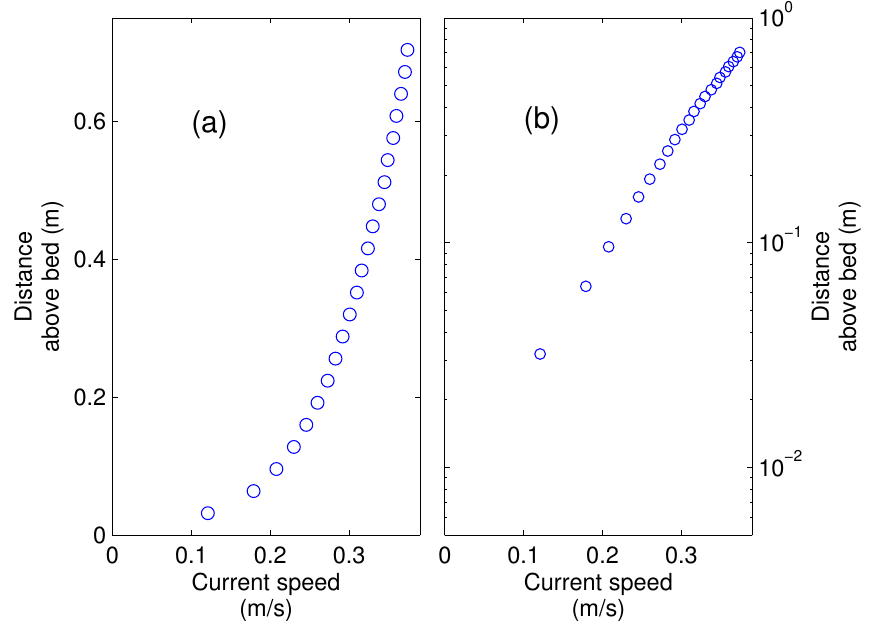
Figure 5. Vertical structure of near-bed current measurements as a function of distance above bed in ( a ) linear scale; and ( b ) logarithmic scale. The measurements correspond to the peak wind event on 31 March 2008 10:00 with 1 m wave height, 10 m/s winds, and 0.4 m/s currents at 70 cm above